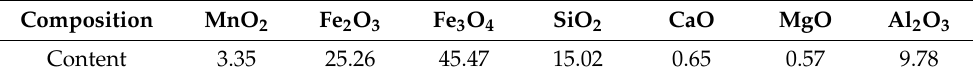
Figure 13. Effect of S 2 /MnO 2 molar ratio on the leaching ratio of Mn (450 °C, 30 min). Table 4. Main chemical composition of the leached residue, wt%. Composition